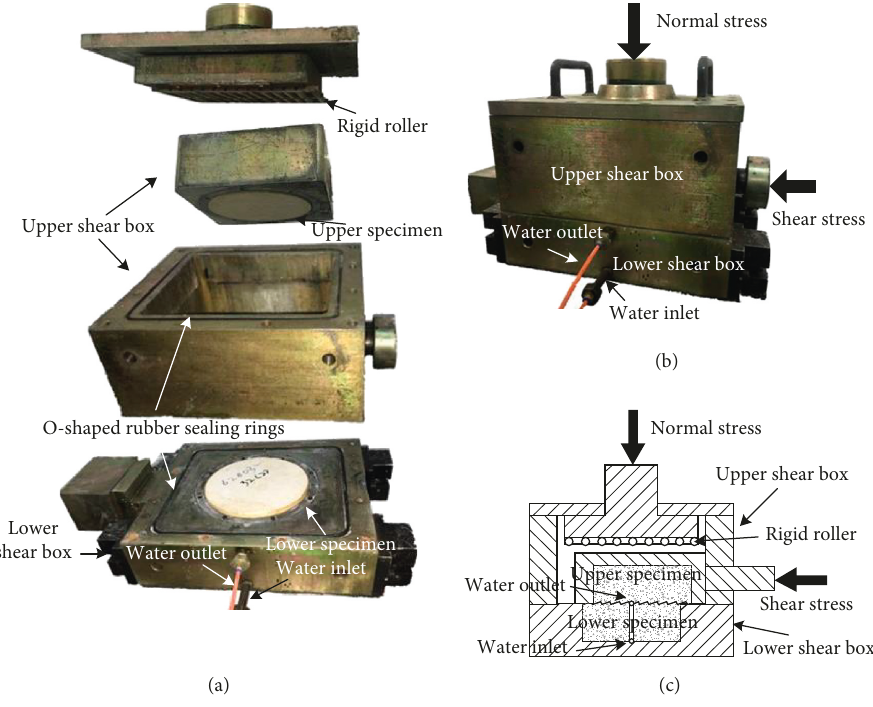
Figure 2: Schematic of the shear box